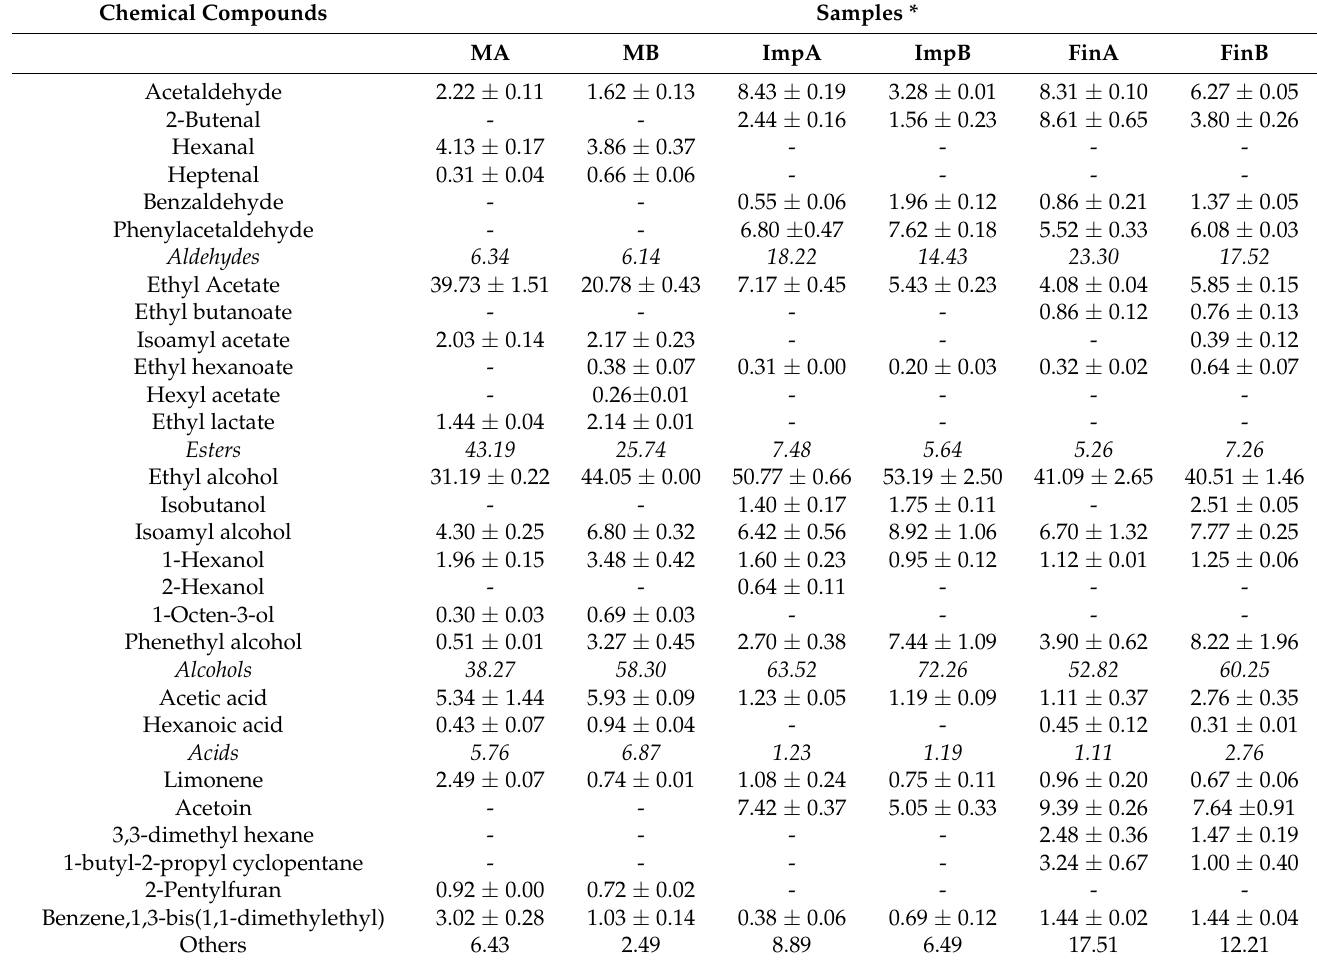
Table 5. Relative volatile organic compound (VOC) composition of sourdough and dough